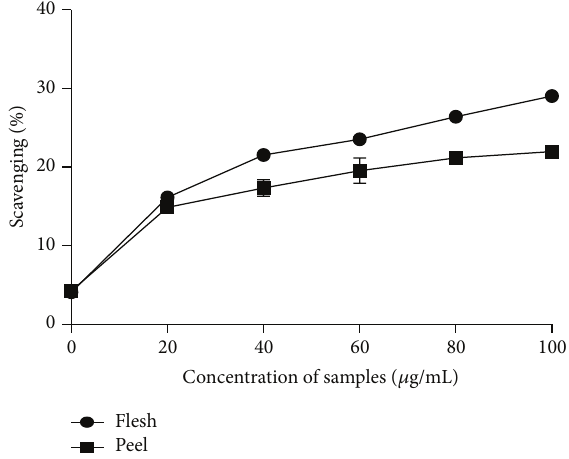
Figure 4: The anticholinesterase activity (%) of different parts of C. betacea for 80% methanol extract and aqueous extract ( 𝑛 = 3